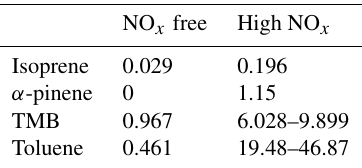
Table 2. Derived imaginary part of refractive index ( k ) of brown carbon formed from various VOC precursors at 365nm. Tabulated values are k × 10 3